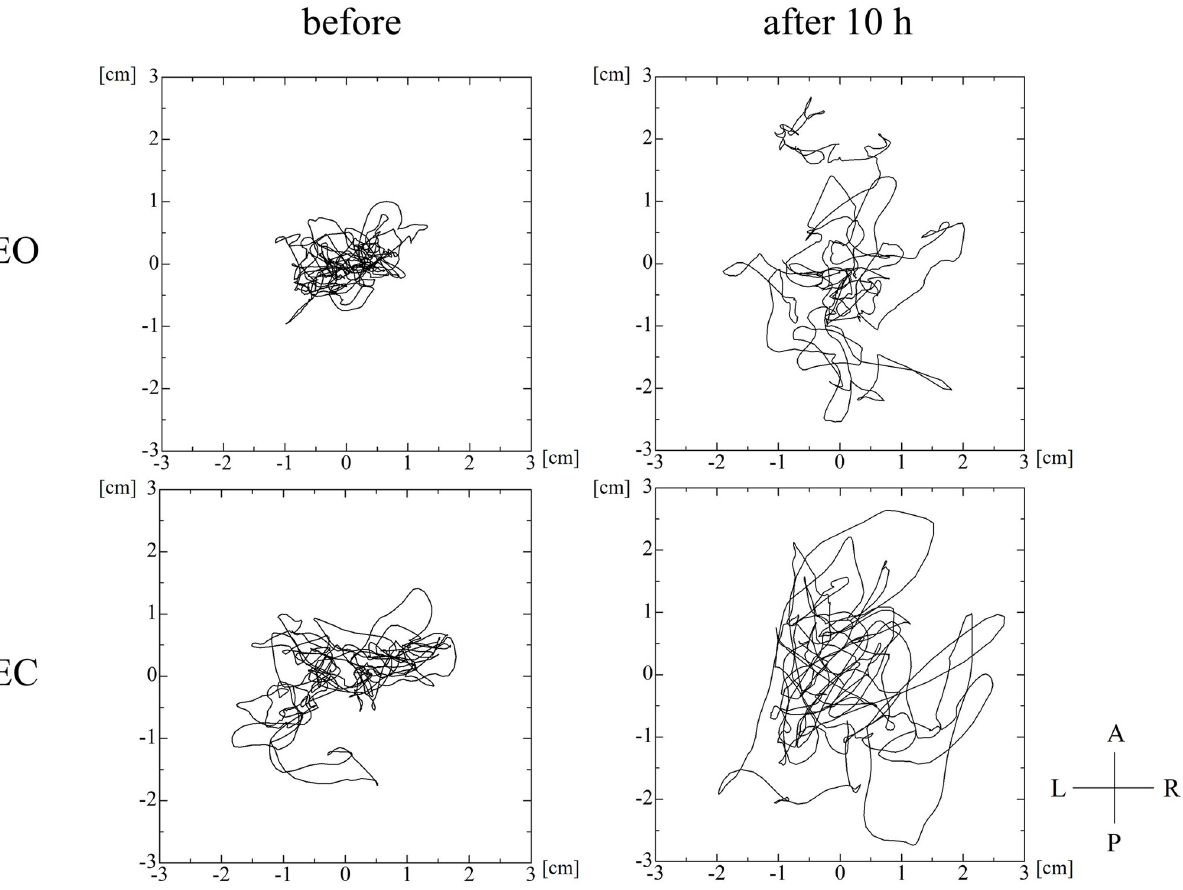
Fig 1. Total path followed by the center of pressure during the trials in one participant. EO: Eyes-open condition, EC: Eyes-closed condition.